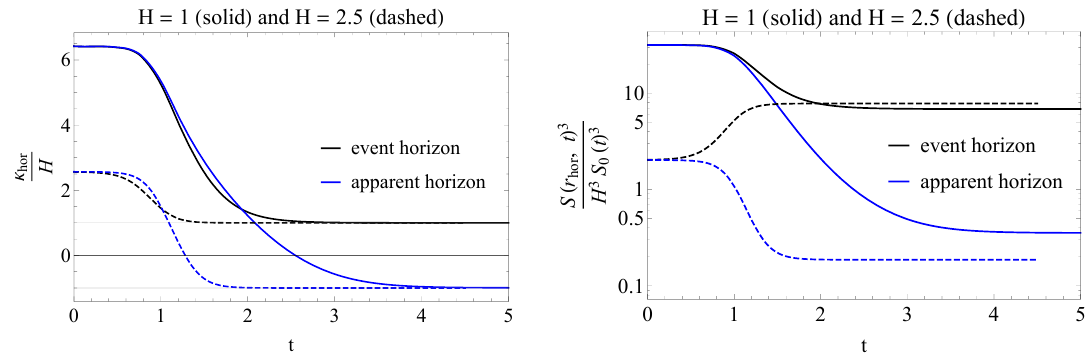
Figure 9 . Surface gravity κ (left) and area density (right) of event and apparent horizons for two different values of the Hubble